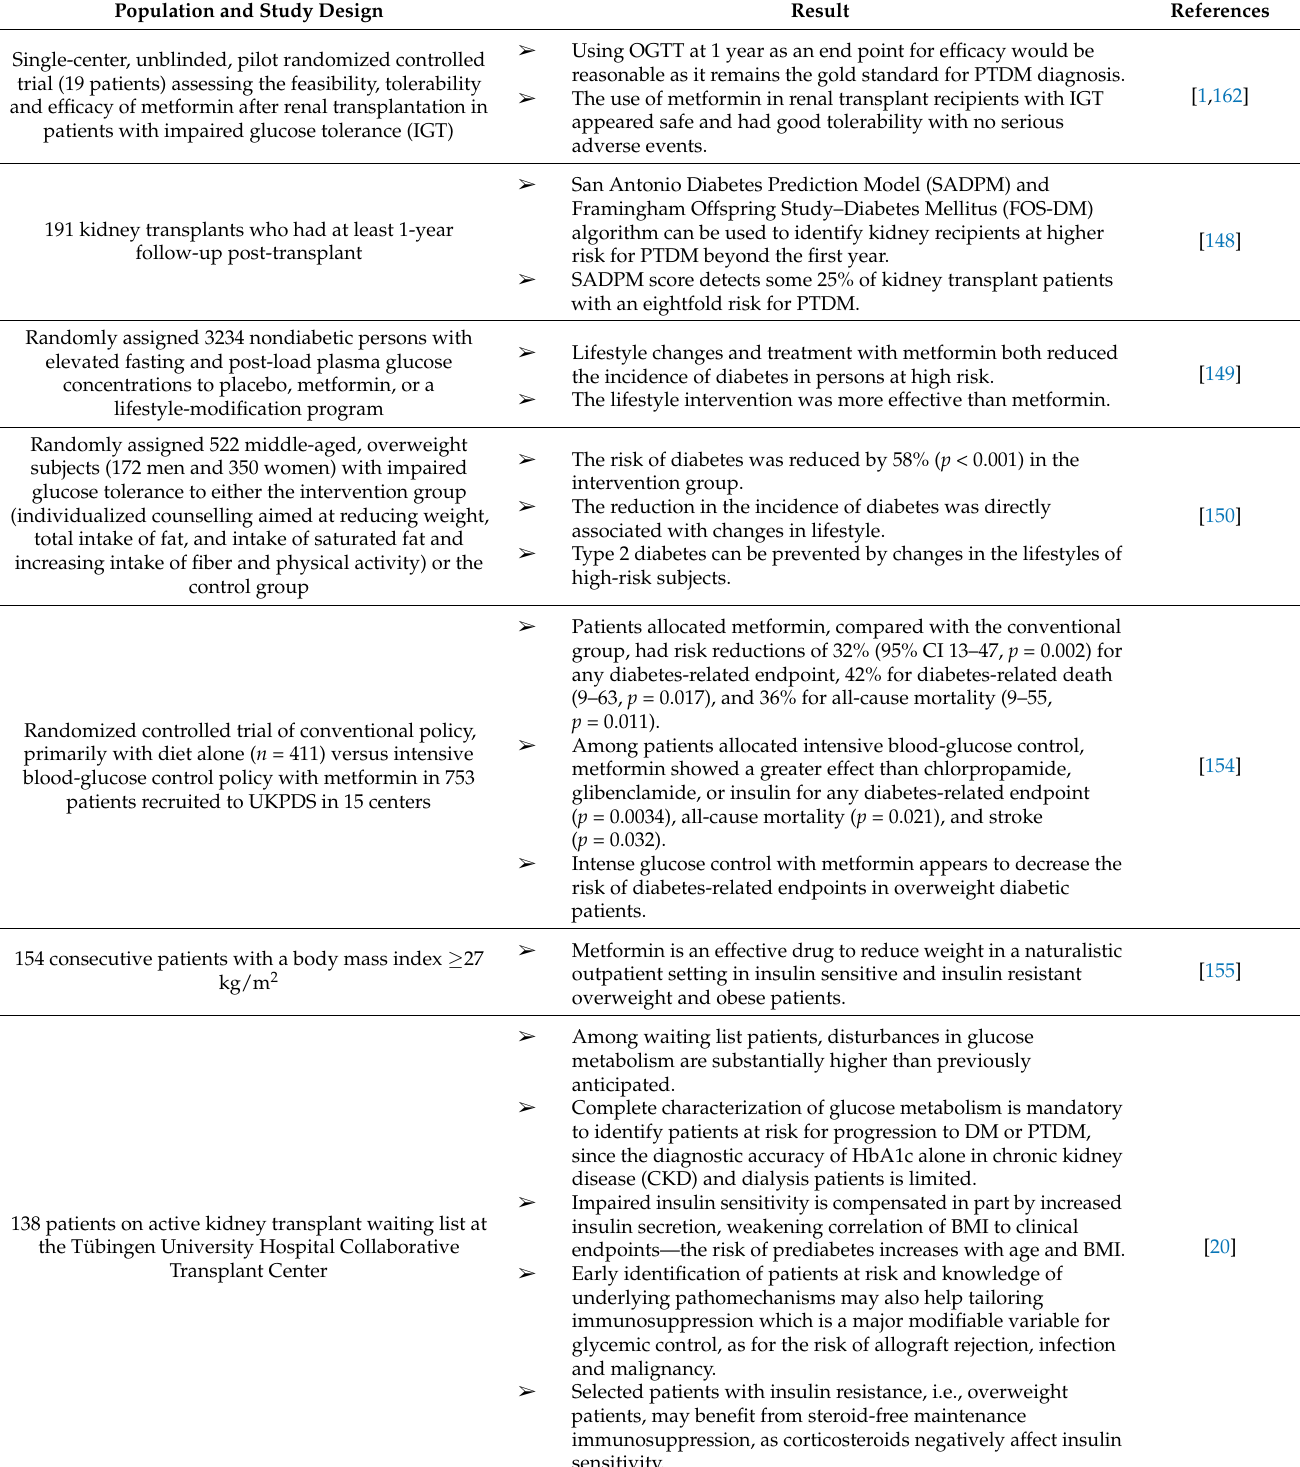
Table 2. The summary of results of studies concerning the diagnosis as management of